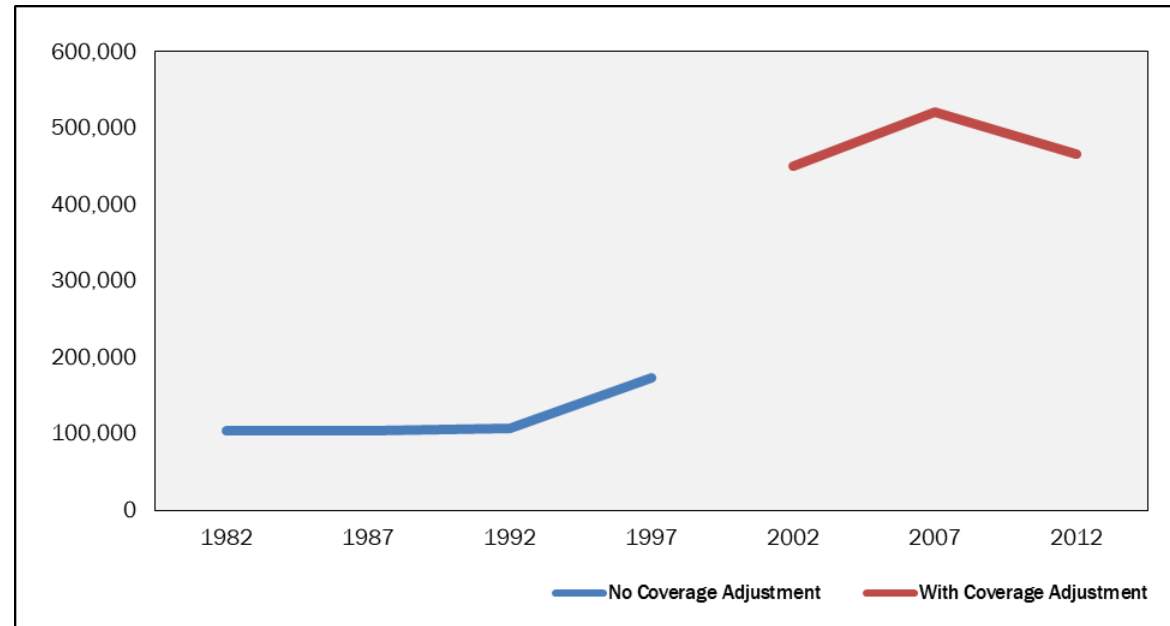
Figure 1. Number of Principal Operators with Zero Sales, 1982–2012